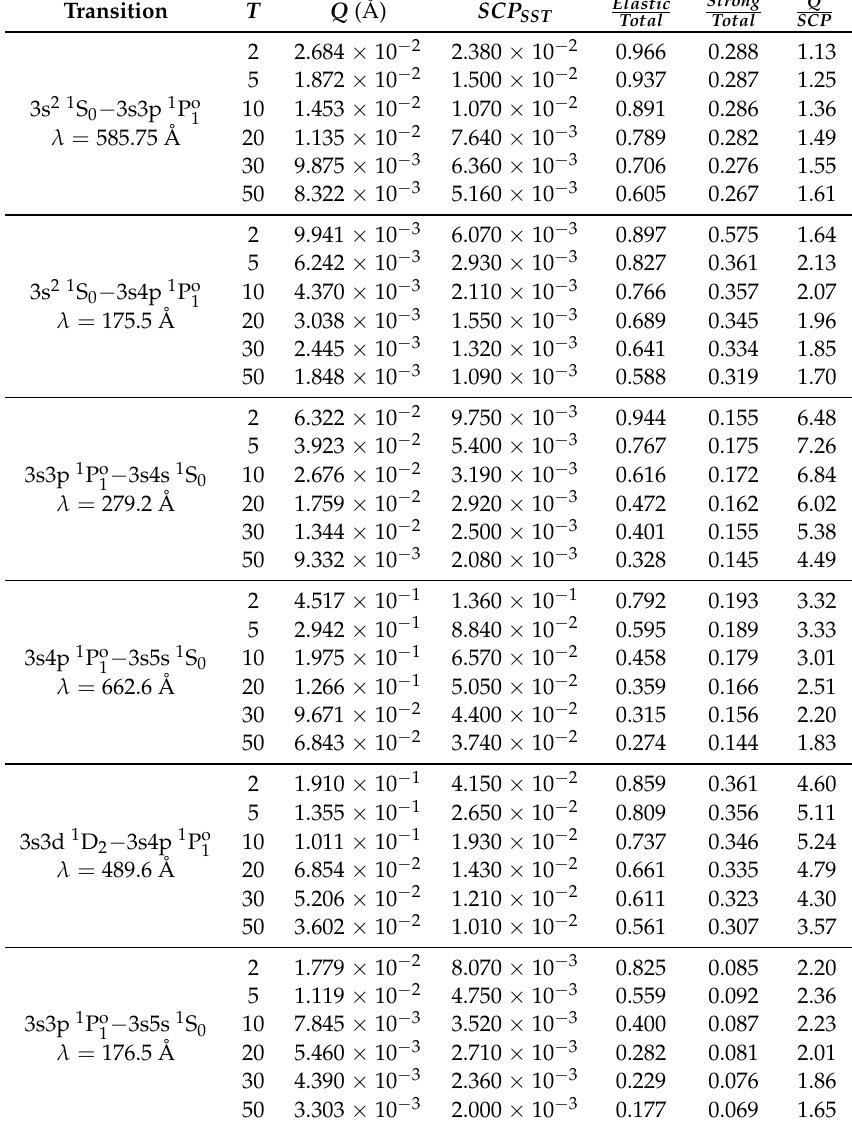
Table 4. Our Stark line widths (FWHM) Q for Ar VII at electron density N e = 10 18 cm − 3 compared to the semiclassical results SCP SST obtained using the atomic data of the code SST. Elastic respectively the contributions of elastic and strong collisions to SCP line broadening. T is expressed in 10 4